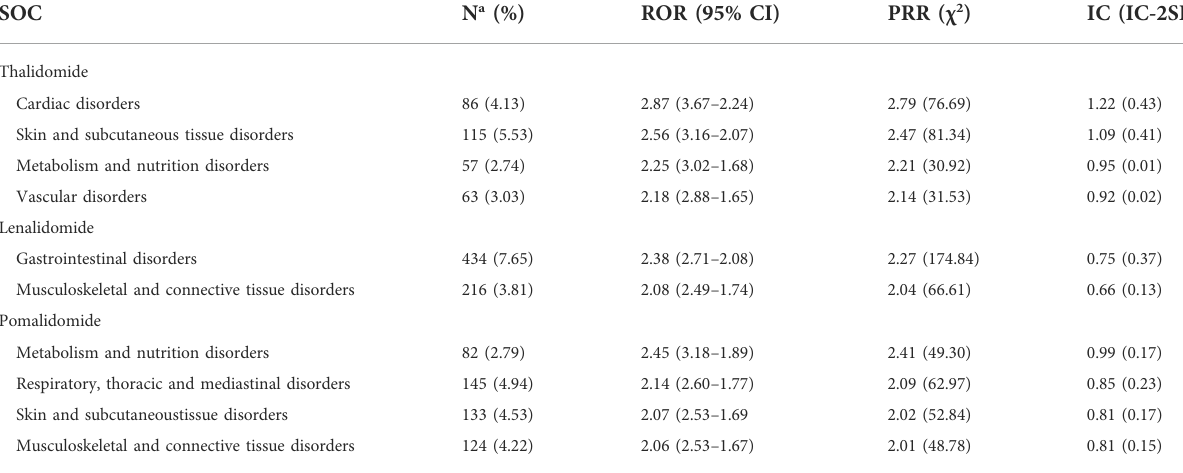
TABLE 3 Detected signi fi cant safety signals based on system organ class (SOC).